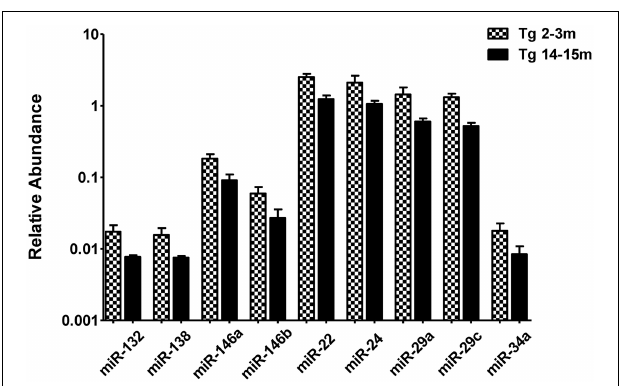
FIGURE 4 | Significant differences in the abundance of plasmatic miRNAs between aging groups analyzed by qRT-PCR. The graph depicts the relative abundance (mean ± SD) of each one of the miRNAs that show statistically significant differences ( t -test; p < 0 . 05) in plasma levels between 14–15 months-old WT and 3xTg-AD mice. Relative abundances were calculated with the difference of the Ct of each miRNA and the Ct of the miR-39 of C. elegans mimics ( (cid:2) Ct) using the formula 2 − (cid:2) Ct . Determination of circulating miRNA profiles included plasma samples from six-seven animals per group and a total of four experimental groups were integrated: 2–3 months old-3xTg-AD mice ( n = 3), 2–3 months old-WT mice ( n = 3), 14–15 months old-3xTg-AD ( n = 3), and 14–15 months old-WT mice ( n = 3) ( n =